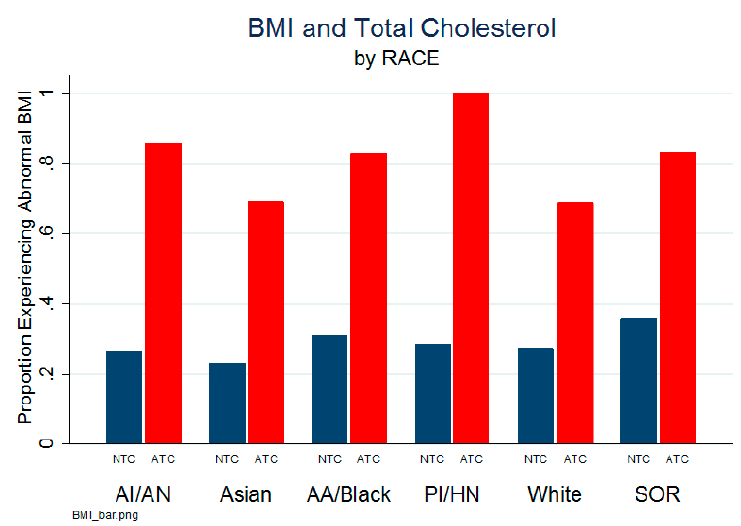
Figure 1. BMI and total cholesterol by race. NTC: Normal total cholesterol, ATC: abnormal total cholesterol.